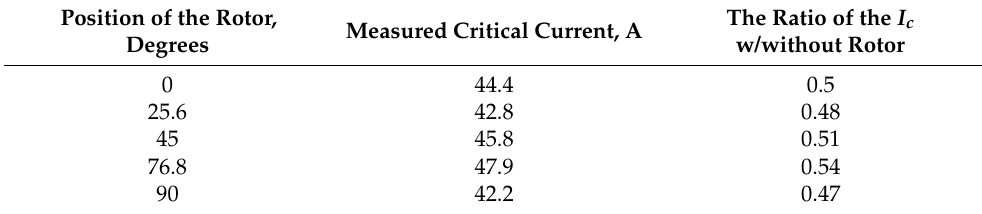
Table 2. Critical current of the phase at different rotor positions. Position of the Rotor, Measured Critical Current, Degrees